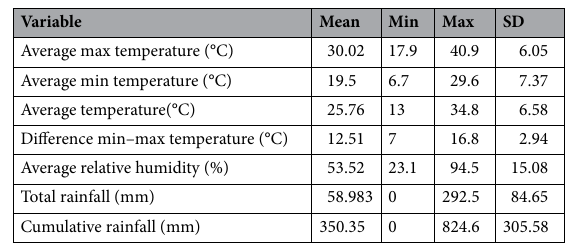
Table 1. Descriptive analysis of environmental data of Delhi, 2015–18 (48 months). SD standard